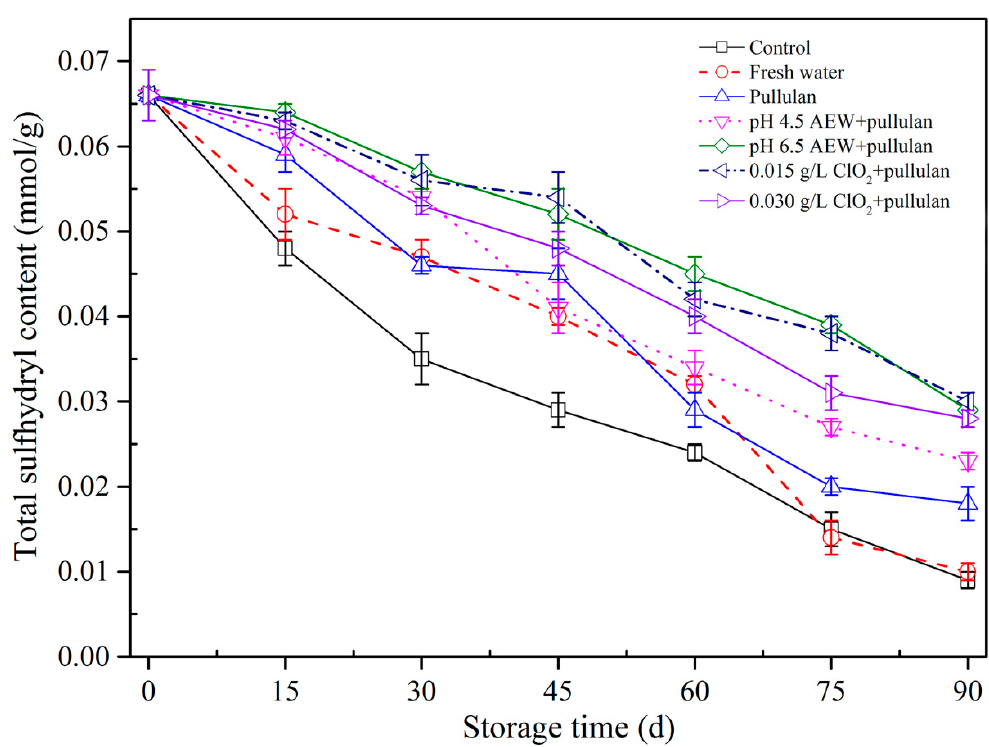
Figure 6. Total sulfhydryl content of half-shell mussels treated with the control, water, and combined glazing solutions during 90 days of frozen storage.